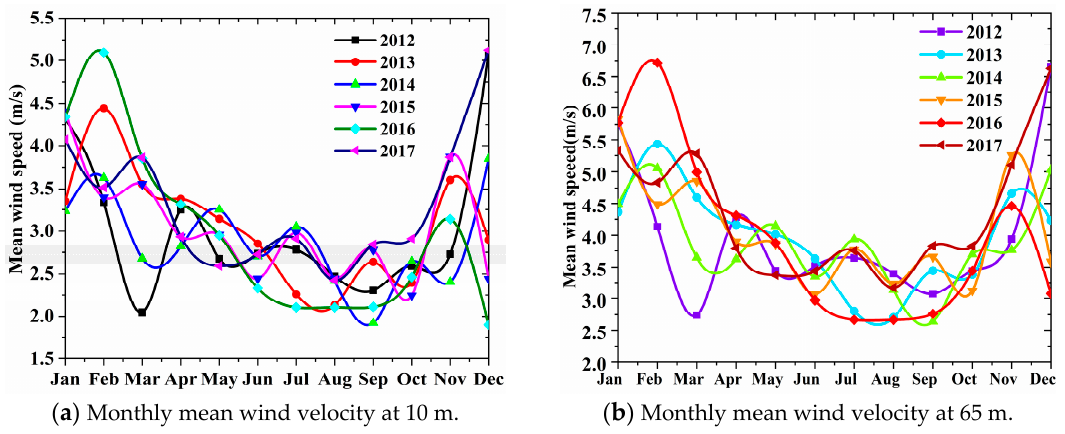
Figure 4. Monthly mean wind speed for 10 m and 65 m from 2012 to 2017.